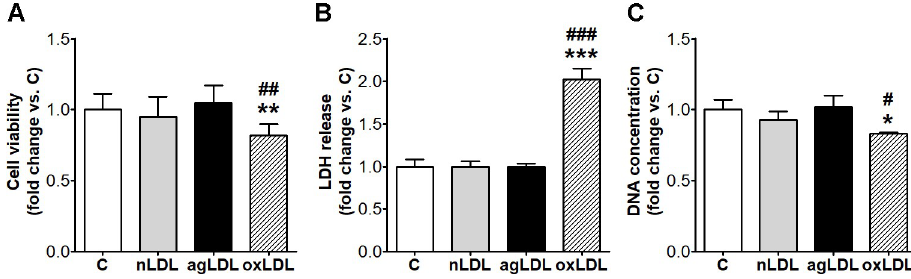
Fig 6. AgLDL do not affect viability of THP-1 macrophages. Cells were exposed for 24 h to 100 μ g/ml aggregated LDL (agLDL), oxidized LDL (oxLDL) or native LDL (nLDL). Cells incubated in the same conditions without LDL were considered control cells (C). (A) Cell viability measured using an assay based on tetrazolium salt (MTT). (B) Lactate dehydrogenase (LDH) release in the culture medium assessed using CytoTox-ONE ™ Homogeneous Membrane Integrity Assay. (C) Cell proliferation assessed by Hoechst 33258 fluorimetric assay, expressed as μ g DNA. All data are represented as fold change versus C and presented as mean ± SD (n = 4). � p < 0.05, �� p < 0.01, ��� p < 0.001 vs. C; # p < 0.05, ## p < 0.01, ### p < 0.001 vs. nLDL.